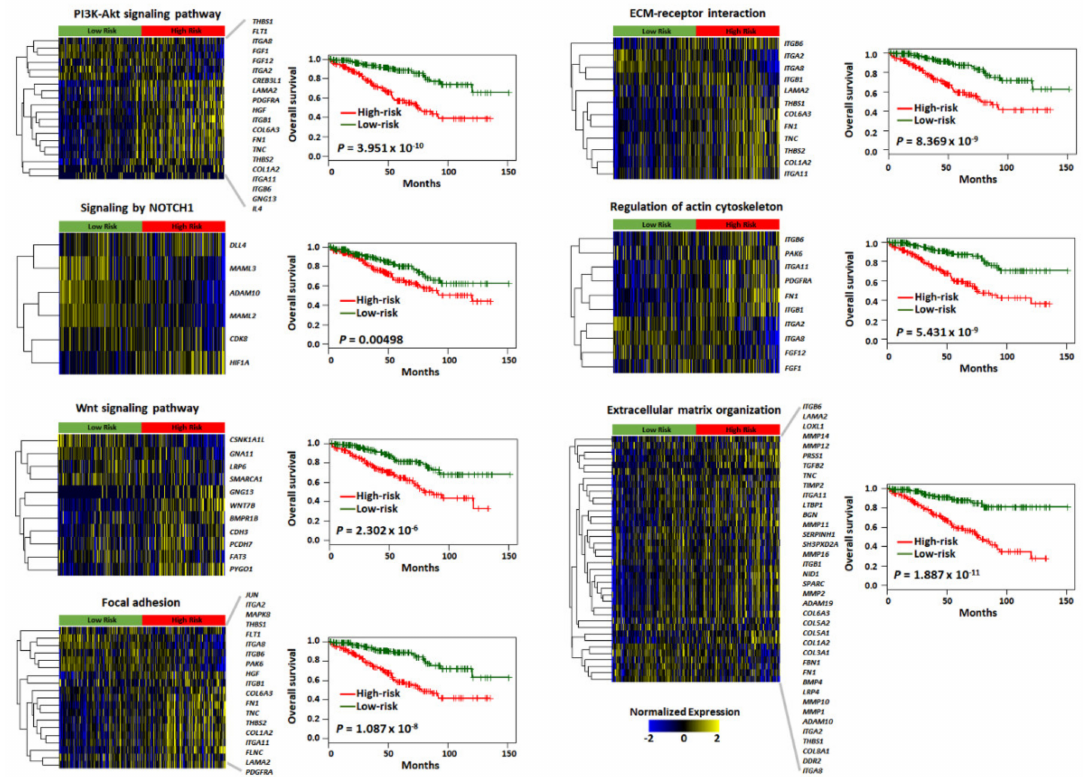
Figure 5. Prognostic significance of major signaling pathways associated with four radiomic features in the genomic validation cohort. The heatmap and Kaplan–Meier curves showing each gene signature score and overall survival di ff erence for high- and low-risk groups via the PI3K / Akt signaling pathway, NOTCH1 signaling, Wnt signaling pathway, focal adhesion, ECM–receptor interaction, regulation of actin cytoskeleton, and extracellular matrix